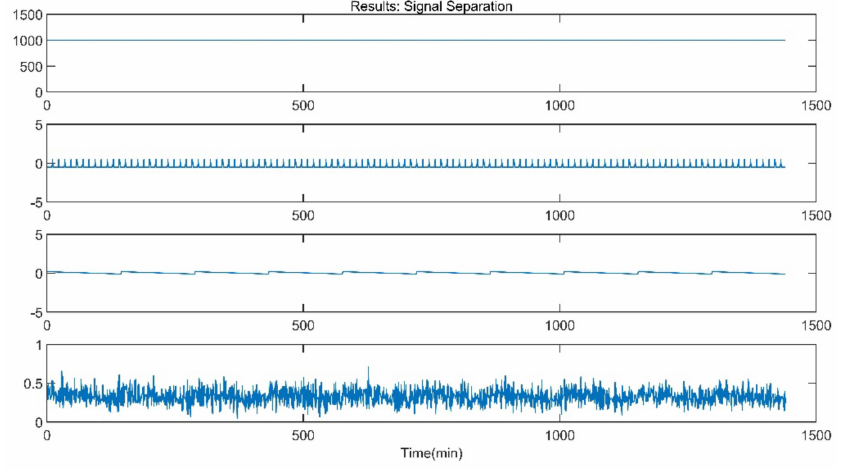
Figure 7. Separation Result (Stable Operation).